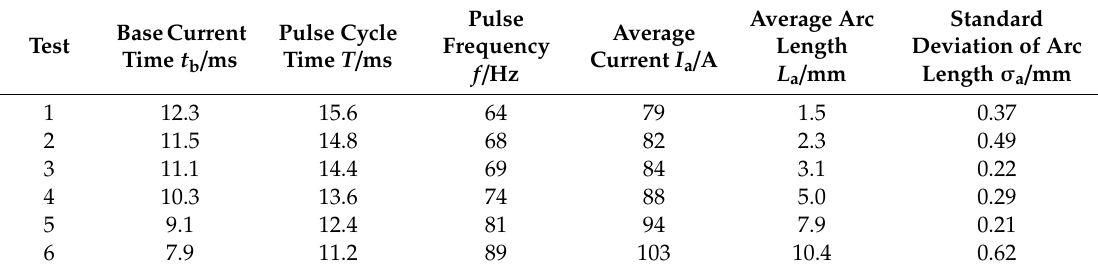
Table 1. The parameters table of pulse waveform and